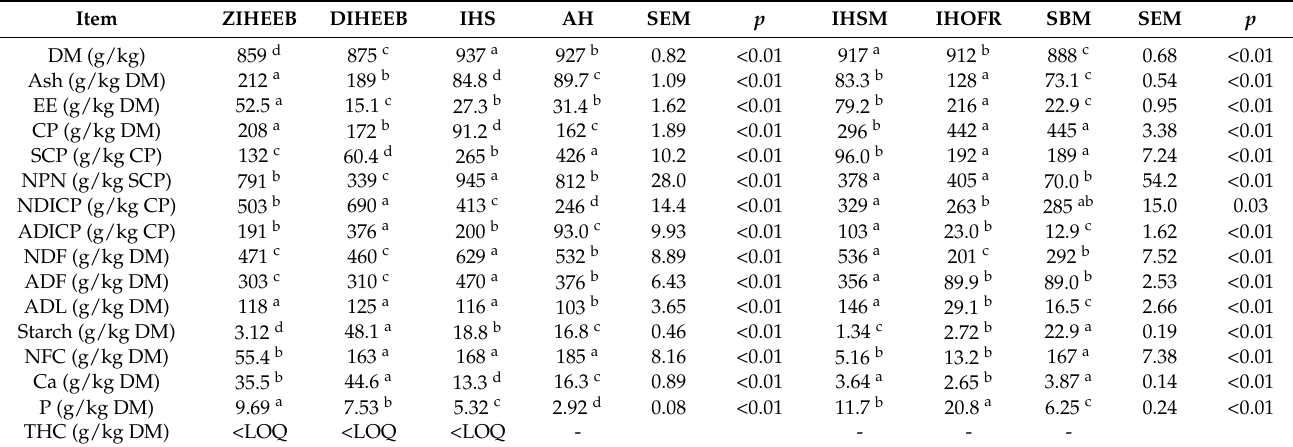
Table 1. Chemical composition of industrial hemp byproducts and conventional